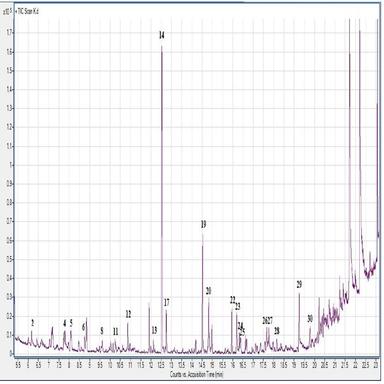
GC–MS chromatogram of bio-oil of the carbonized material at 850 °C.